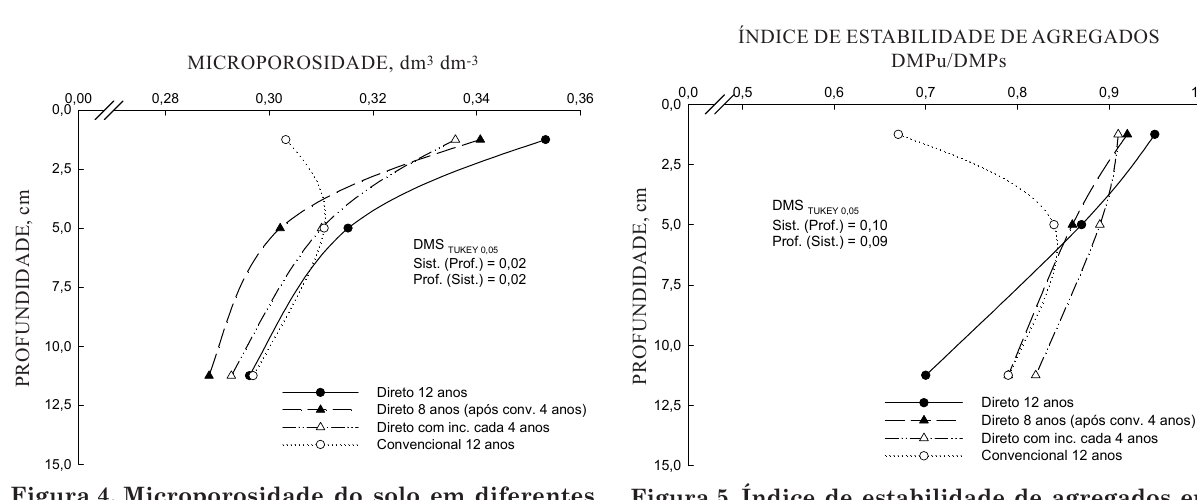
Figura 5. Índice de estabilidade de agregados em diferentes sistemas de manejo e profundidades.